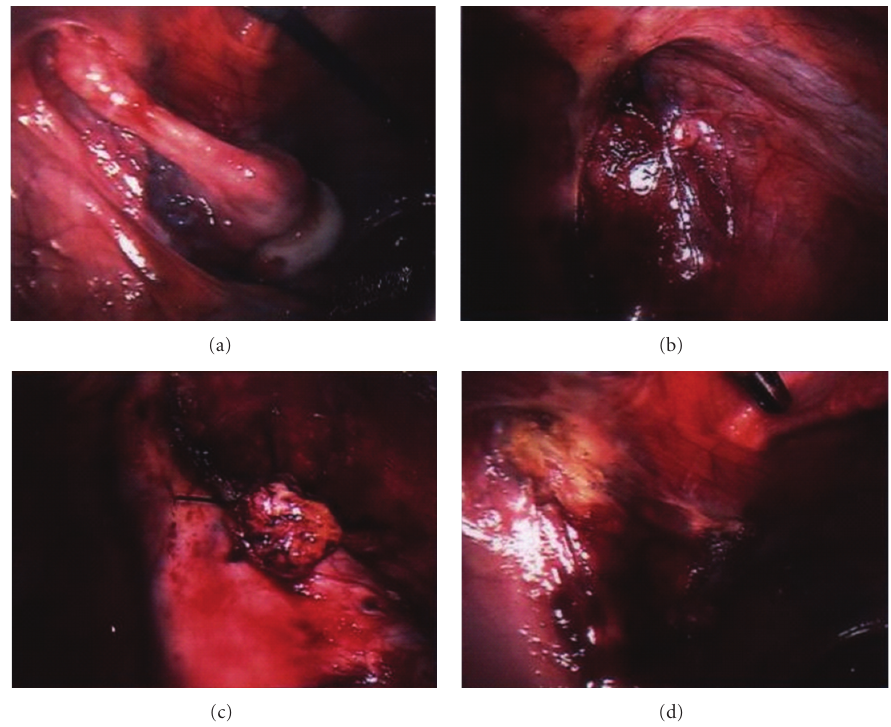
Figure 1: Laparoscopy pictures. (a) Left adnexa. (b) Right adnexa. (c) Left side after gonadal removal. (d) Right side after gonadal removal.